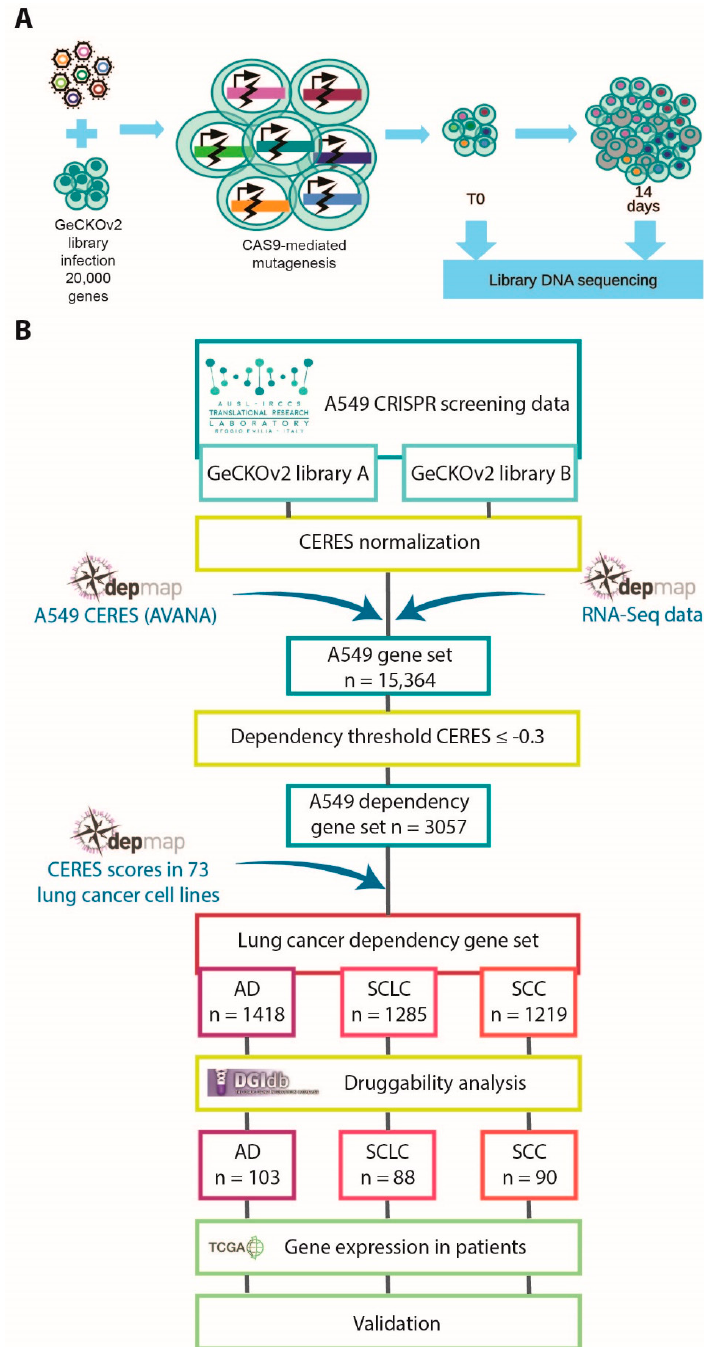
Figure 1. Overview of the performed analyses: ( A ) schematic representation of the CRISPR/Cas9 screening procedure; ( B ) schematic representation of the integrated bioinformatics and functional genomics approach that we applied to identify novel drug target candidates in lung cancer.